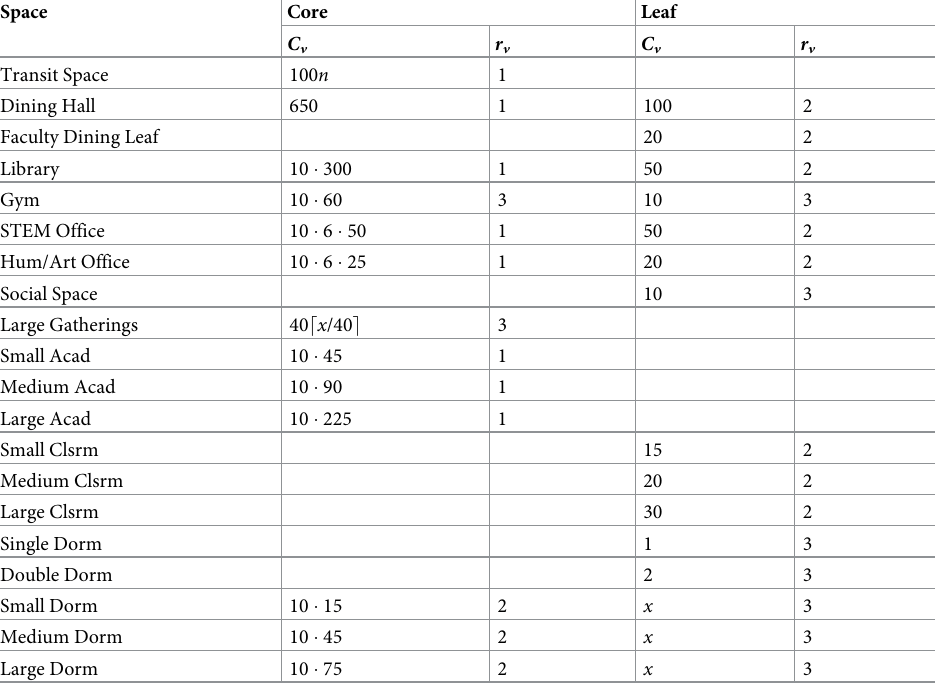
Table 3. The core and leaf capacity and risk multiplier for different buildings. The quantity x is the number of peo- ple assigned to that space.